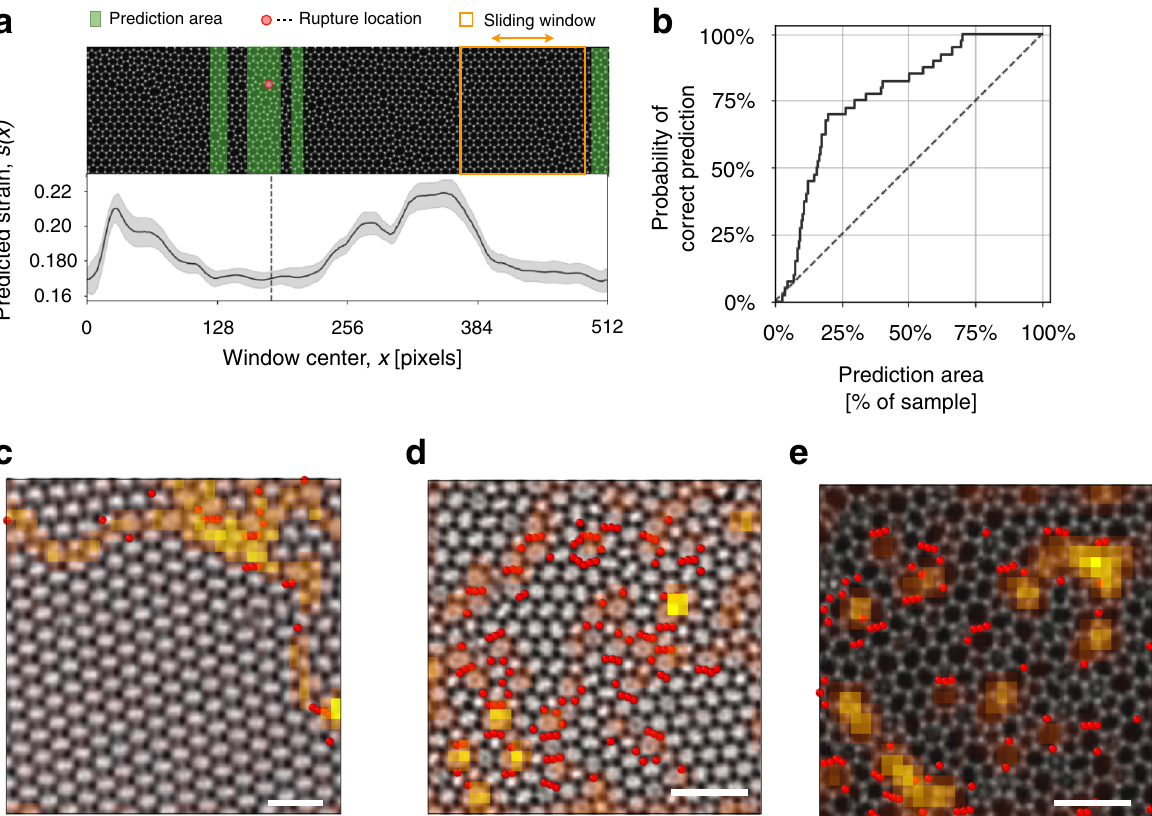
Fig. 6 Transfer learning to tackle larger samples and real experiments. a Transfer learning on sample of larger size. The ResNet model, originally trained on 128x128 pixels samples to predict rupture strain, is used to predict the rupture strain of different regions of the shown larger silica sample, of size 512x128 pixels. When this sample is stretched by MD it produces the rupture event (bond breaking) indicated by the red dot and vertical dotted line. In this example, the rupture location lies inside the green prediction area, a region of lowest predicted strain. The predicted strain is computed by sliding the orange window over the whole sample. The shaded grey band corresponds to the standard deviation of the rupture strain computed over all the possible images obtained from the same con fi guration by data augmentation. b Probability of correct prediction ( fi nding the rupture location inside the prediction area) as a function of the size of the prediction area. The diagonal dashed line corresponds to a random guess. The model is able to identify the rupture location with accuracy well beyond the random guess baseline. c – e Experimental TEM images of two-dimensional silica glass samples from 23 are analyzed by the ResNet model trained on simulated data to predict disorder and by SVM classi fi cation. Grad-CAM attention maps G highlight the topological defects. Atoms predicted by SVM to be deforming irreversibly after straining in the horizontal direction are reported in red. Scalebars are 20 Å . Reproduced with permission ( c ) American Chemical